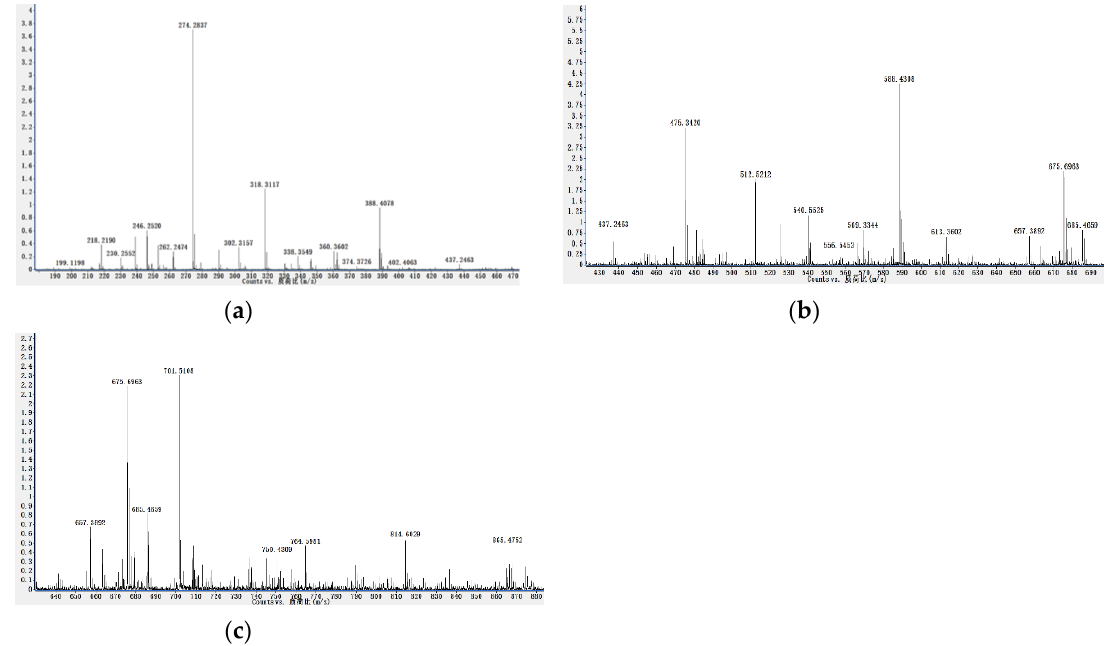
Figure 3. a – c. The full mass spectrum for the purified compound, D2 (N) from Citrullus colocynthis leaves.